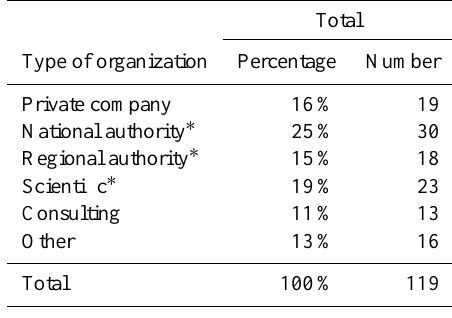
Table 2. Type of